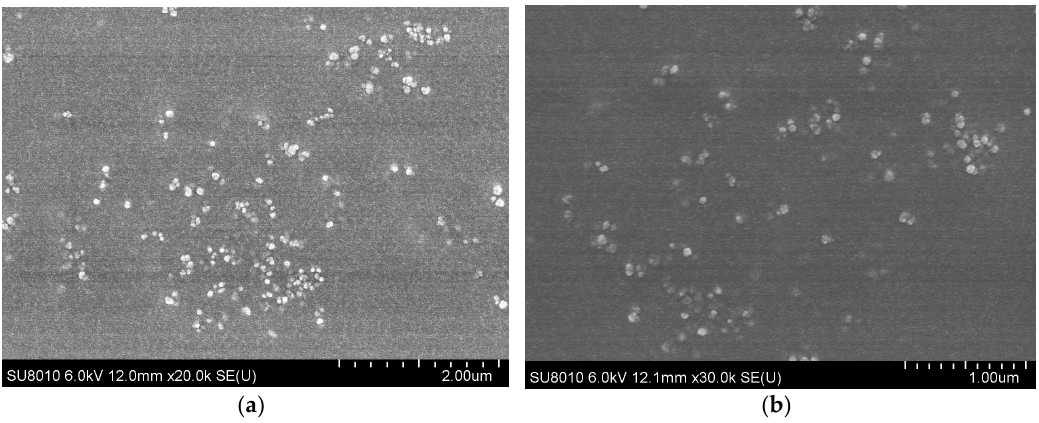
Figure 7. SEM images of microspheres. ( a ) Using PVA as a surfactant, rTgH2A1/PLGA microspheres were prepared using the double emulsion solvent evaporation technique ( w / o / w ). ( b ) rTgH2A1/chitosan microspheres were prepared using the ionic gelation technique.